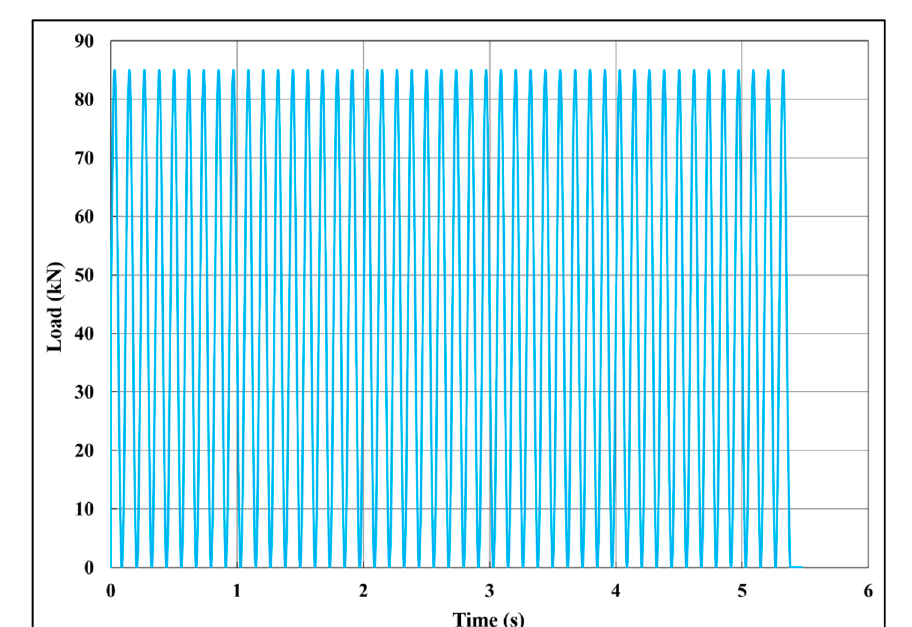
Figure 5. Input motion (10.1 Hz sinusoidal wave).